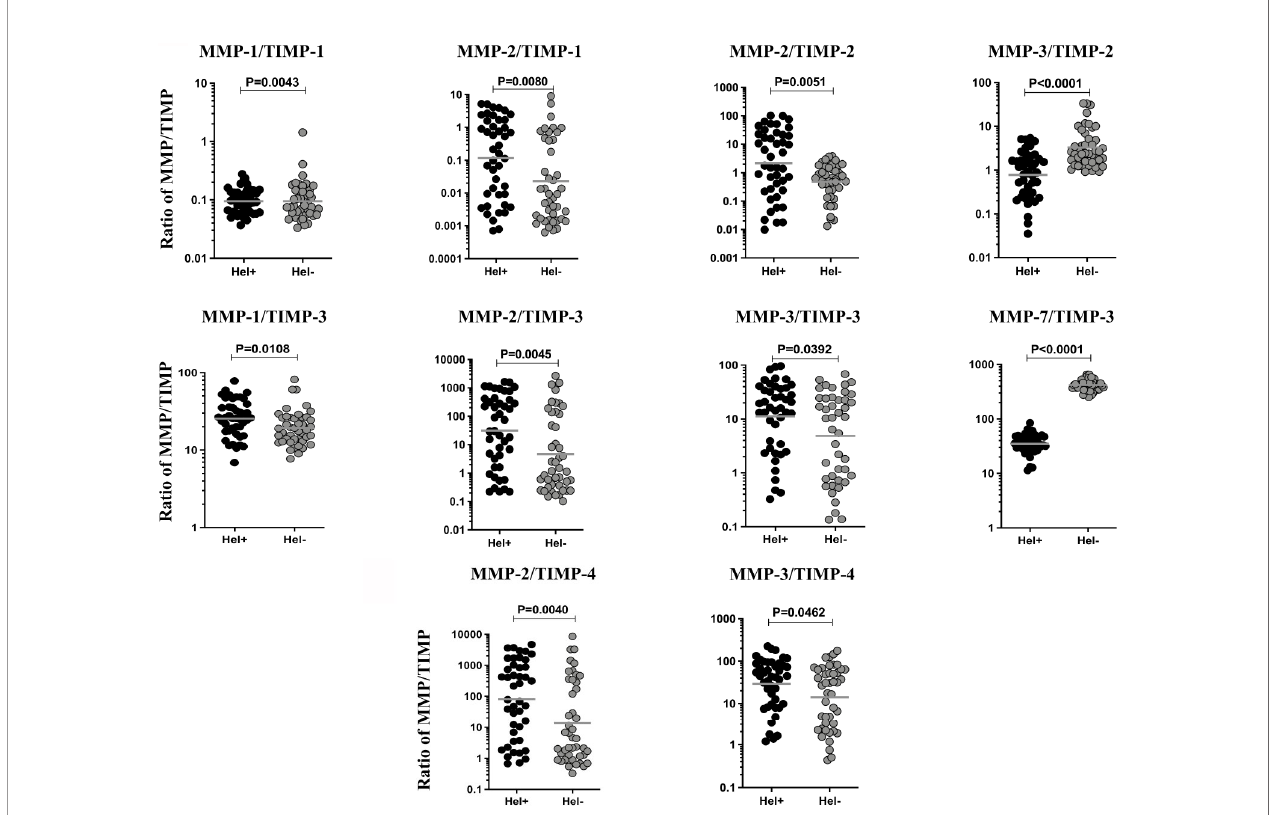
FIGURE 3 | Ratio of MMP/TIMP were altered in TBL-Hel+ coinfected individuals. The ratio of different MMPs (1, 2, 3, 7, 8, 9, 12, 13) and each one of the TIMPs (1, 2, 3, 4) were compared between TBL-Hel+ (n = 44) and TBL-Hel- (n = 44) individuals. The ratios were represented as scatter plots with each circle denoting a single individual and the bar indicating the geometric mean. P values were calculated using Mann-Whitney U test.